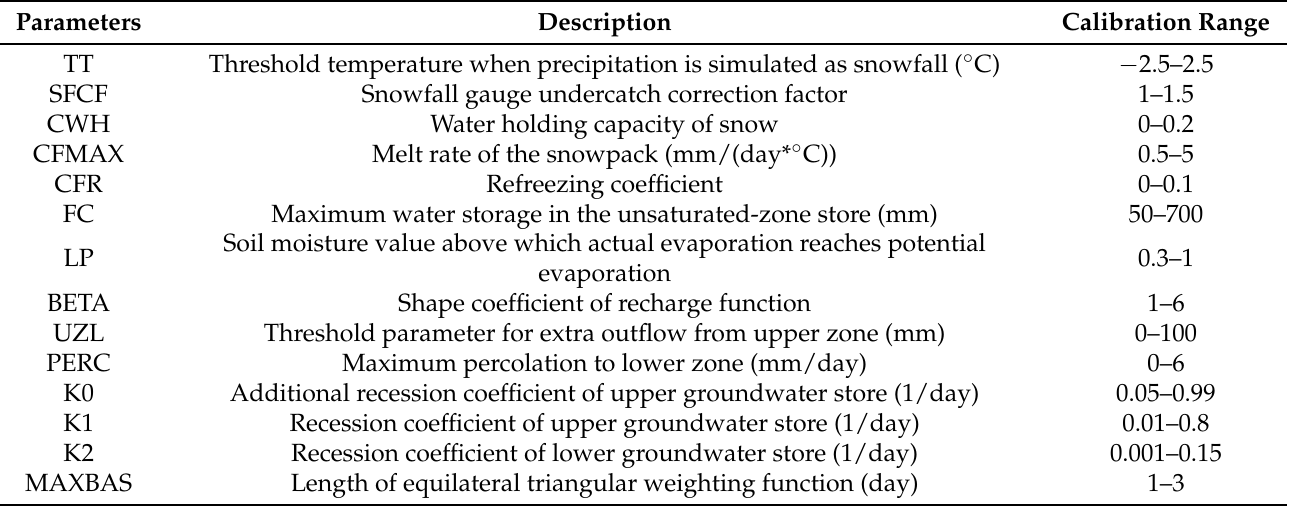
Table 2. Description and calibration ranges for HBV model parameters (based on Beck et al. [45]).